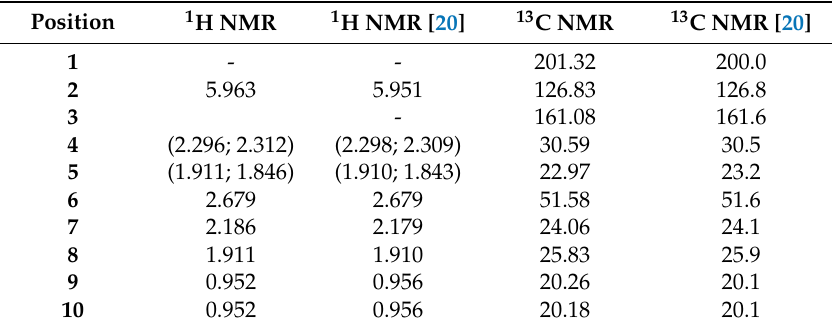
Table 6. NMR data of Piperitone substance (S 27) compared to literature data. Position